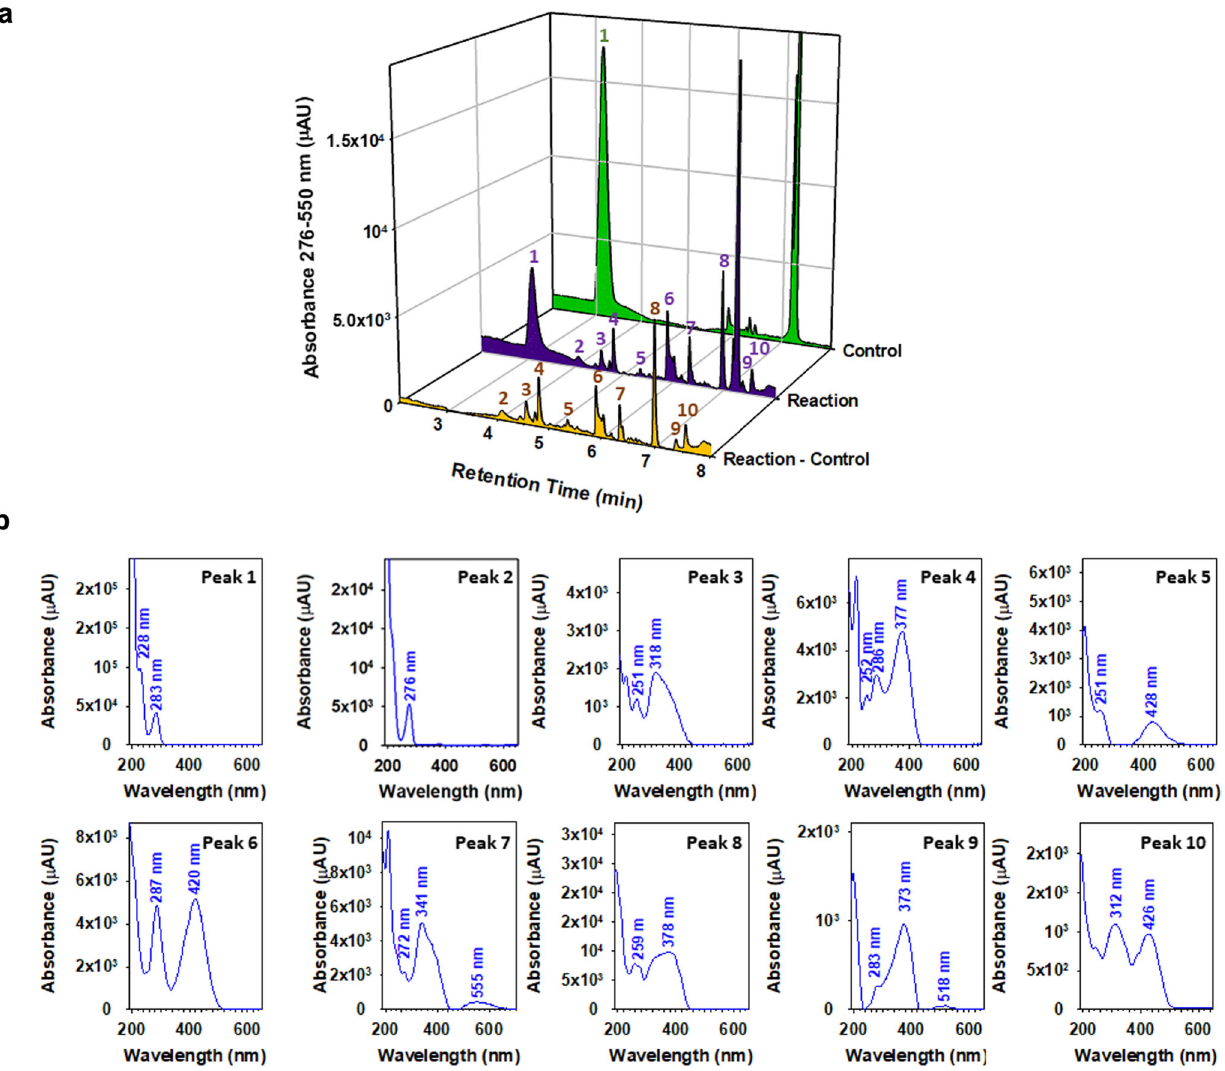
Fig. 3 Chromatographic analysis of soluble products from the reaction of ortho -aminophenol ( o AP) with Fe(III). a UV – visible (276 – 550 nm) chromatogram with additional ESI/MS( + ) detection for the fi ltrates following the overnight reaction of (purple) o AP (labeled as peak 1) with Fe(III) in a 3:1 ratio, (green) a control in the absence of Fe(III), and (yellow) the remaining positive signal after subtraction of the control to the reaction. Labeled product peaks 2 – 10 are discussed in the text. Detailed reaction conditions and concentrations are the same listed in Fig. 1. b Extracted UV – visible spectra of peaks 1 through 10 in the chromatograms of Fig.